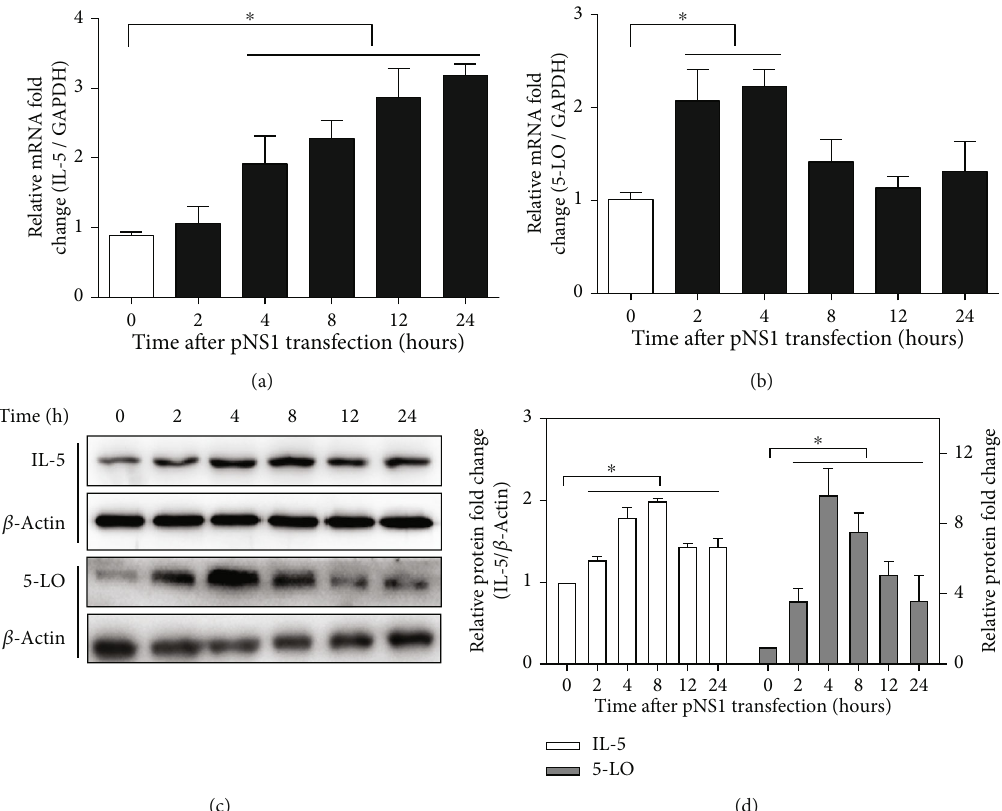
Figure 2: RSV NS1 protein promoted in fl ammatory factor production and increased 5-lipoxygenase (5-LO) expression. (a, b) The expression levels of IL-5 and 5-LO mRNA in A549 cells transfected with pNS1 were detected by RT-qPCR. GADPH was used as an internal control. (c) Western blot analysis of 5-LO protein and IL-5 protein in A549 cells transfected with pNS1. β -Actin served as an internal control. (d, e) Relative quantitative analysis of 5-LO protein and IL-5 protein, respectively. Data are expressed as mean ± SD ( n = 3 technical replicates). The experiment was performed three times with similar results, and one representative experiment is shown. ∗ P < 0 : 5 vs. 0h. 5-LO: 5-lipoxygenase; IL-5: interleukin-5; pNS1: nonstructural protein 1 expressing